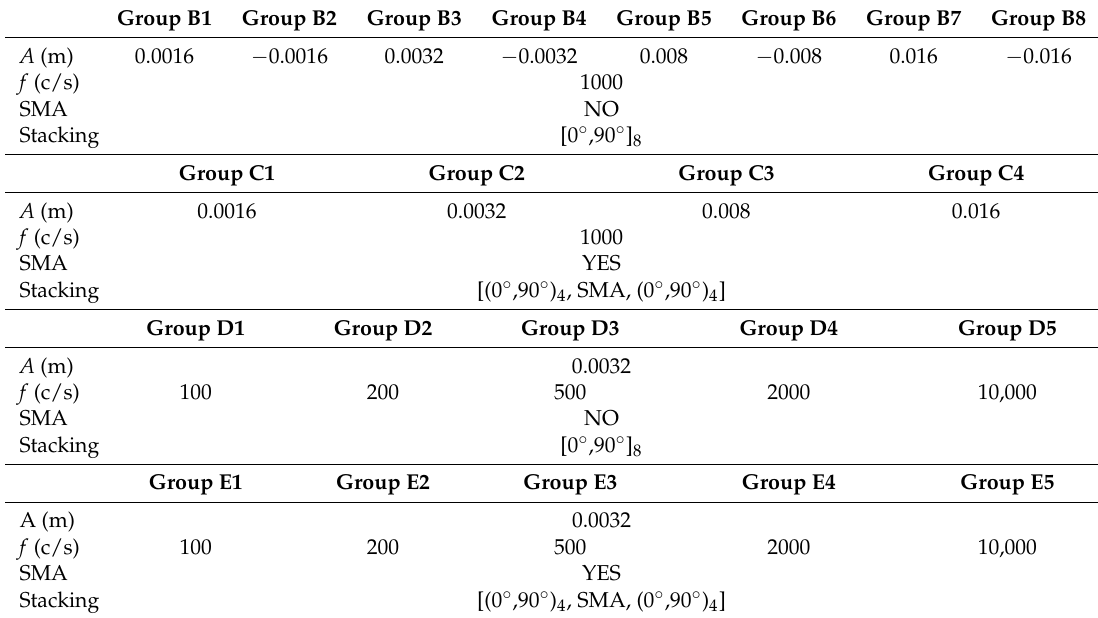
Table 3. The amplitudes and frequencies used in the